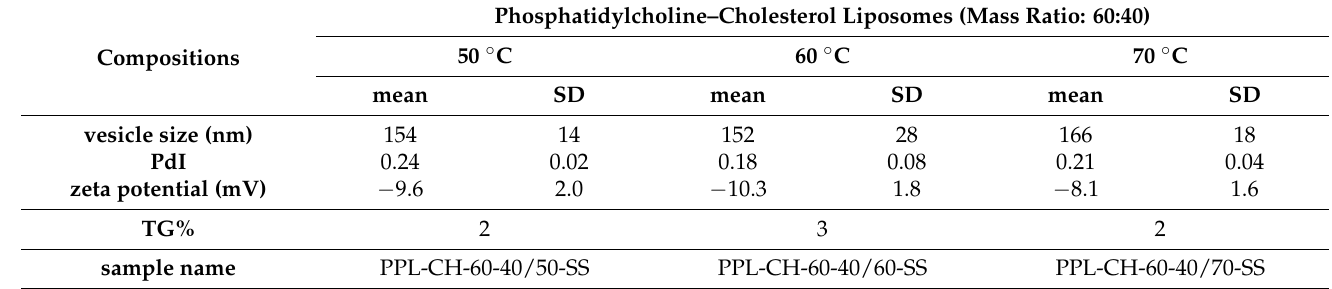
Table 7. Measurement results of the liposome samples prepared at different temperature values (50, 60 and 70 ◦ C) from PC-CH 60:40 mass ratio composition and hydrated with saline